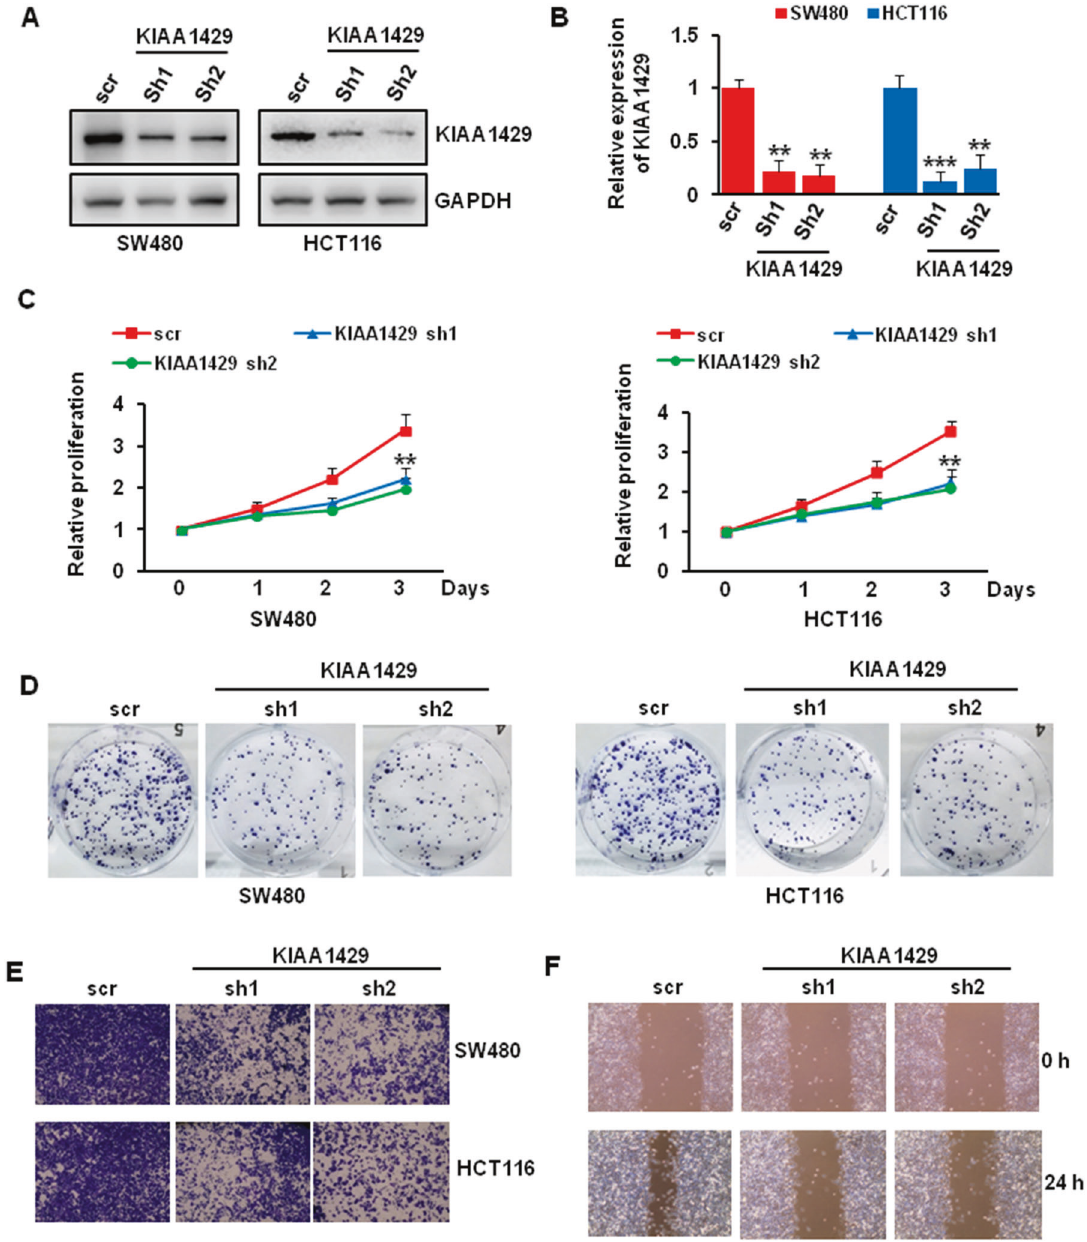
Fig. 3 Effect of KIAA1429 depletion on cells proliferation, colony formation, and migration. A , B The knockdown ef fi ciency of KIAA1429 in colorectal cancer cells was detected by western blotting ( A ) and QRT-PCR ( B ). ** P < 0.01, *** P < 0.001. C The proliferation of SW480